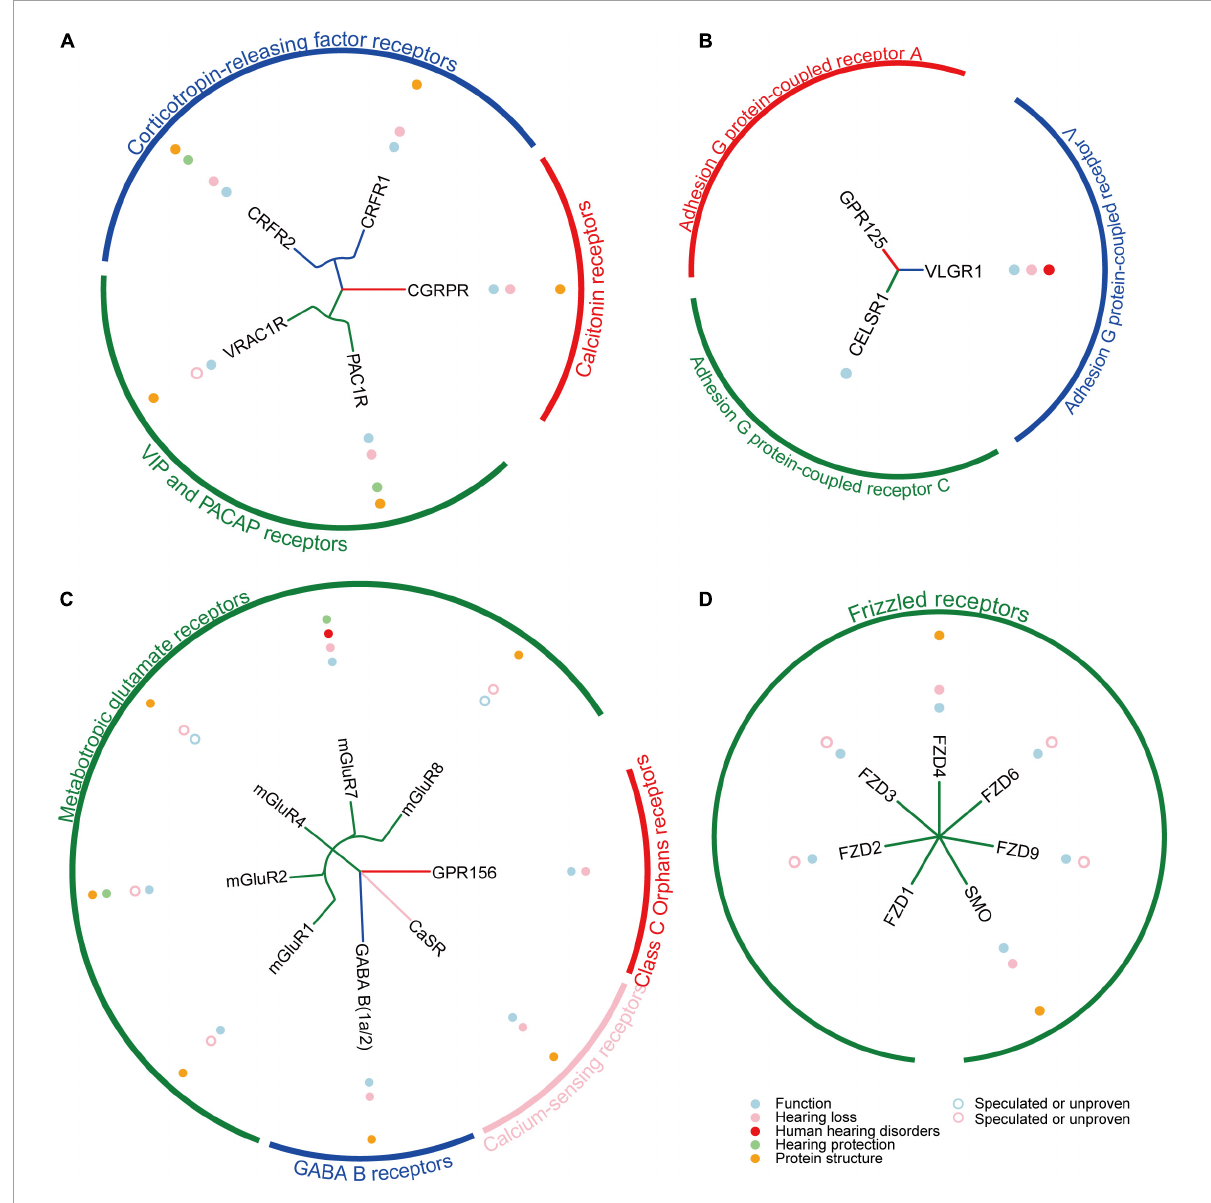
FIGURE3 The summary of reported Class B1/B2/C/F GPCRs in cochlea. (A) The summary of reported 5 Class B1 GPCRs in cochlea. (B) The summary of reported 3 Class B2 GPCRs in cochlea. (C) The summary of reported 8 Class C GPCRs in cochlea. (D) The summary of reported 7 Class F GPCRs in